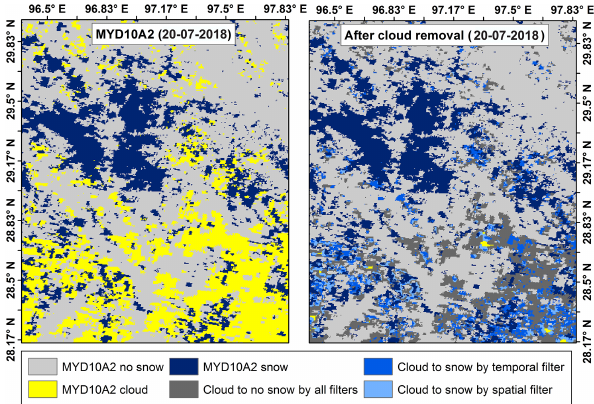
Figure 4. Map showing cloud conversion to snow and no snow by temporal and spatial filters in MYD10A2 image.